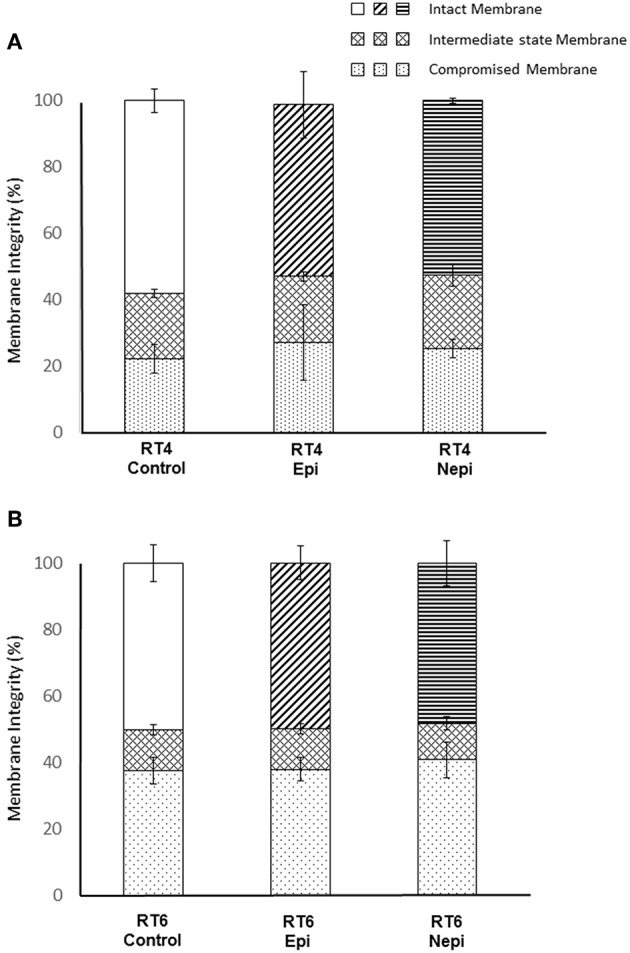
Evaluation of membrane integrity of RT4 acneic (A) and RT6 non-acneic (B) strains of Cutibacterium acnes grown in the presence or absence of epinephrine (Epi) or norepinephrine (Nepi) (10−6 M). Membrane integrity was classified as “intact,” “intermediate state,” or “membrane” following labeling using the LIVE/DEAD™ BacLight™ Bacterial Viability Kit and flow cytometry analysis. Results are shown as the mean ± SEM of data acquired from 100,000 events.